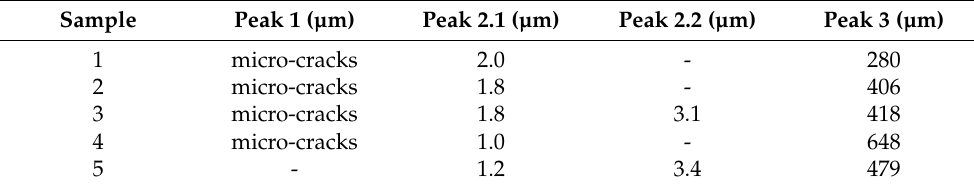
Figure 3. Mercury porosimetry results—logarithm differential intrusion of mercury. Table 2. Mean values of the pore sizes from microscopic (via mercury porosimetry) and macroscopic pores (via